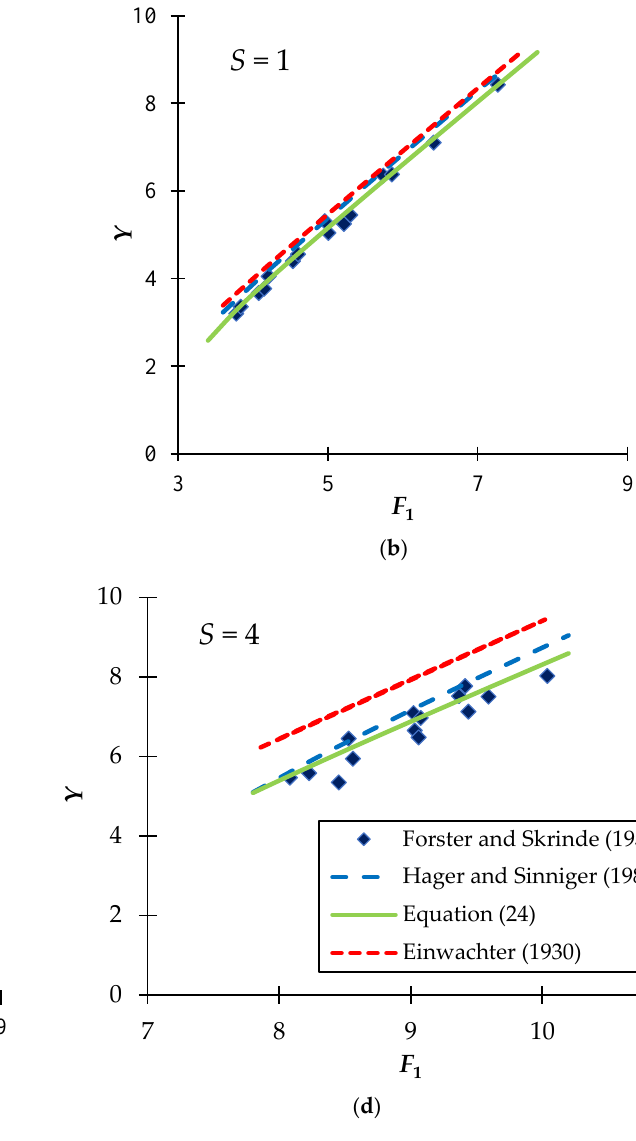
Figure 6. Conjugate flow depth variation with initial Froude number for different relative step heights: ( a ) S = 0.5; ( b ) S = 1; ( c ) S = 2; ( d ) S = 4.